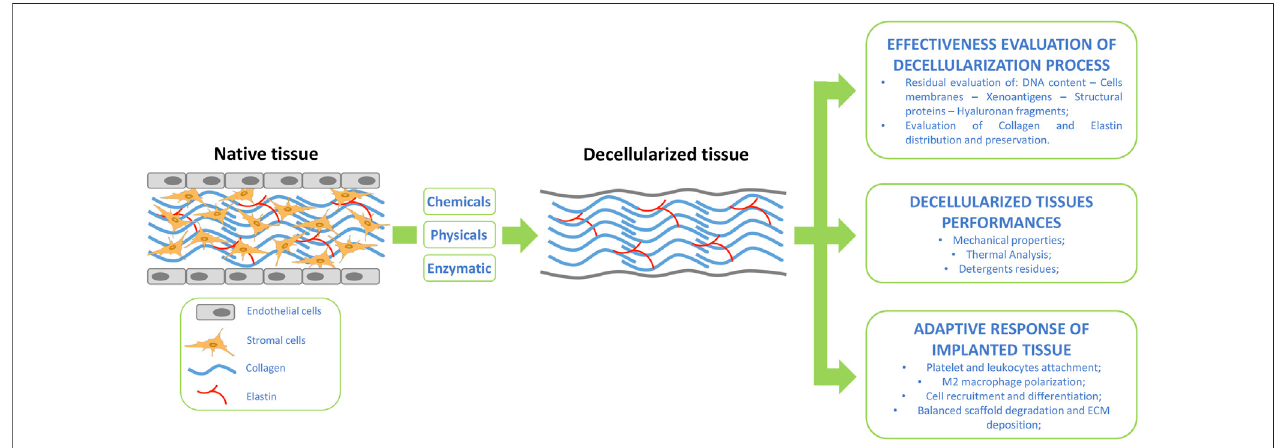
FIGURE 1 | Tissue decellularization fl ow-scheme supported by suggested assessment for post tissue treatment evaluation and implanted graft integration.